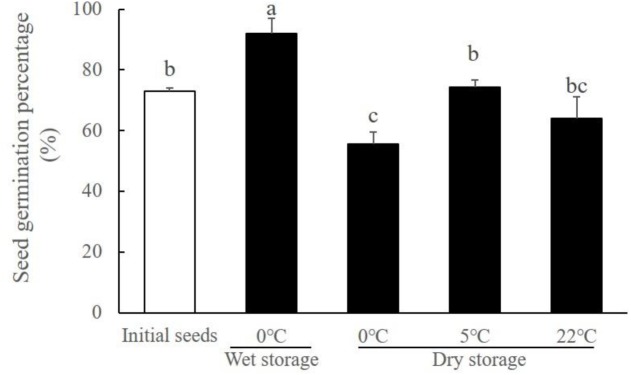
Ruppia sinensis seed vigor after storage for 9 months (Black bars) in dry conditions at different temperatures and in wet conditions at 0°C and 30 psu. The white bar represents initial seed germination percentage before the storage (Gu et al., 2017). Different letters a, b, and c indicate significant difference between treatments. All seed germination percentage was determined under the optimal germination conditions (30°C and 5 psu).